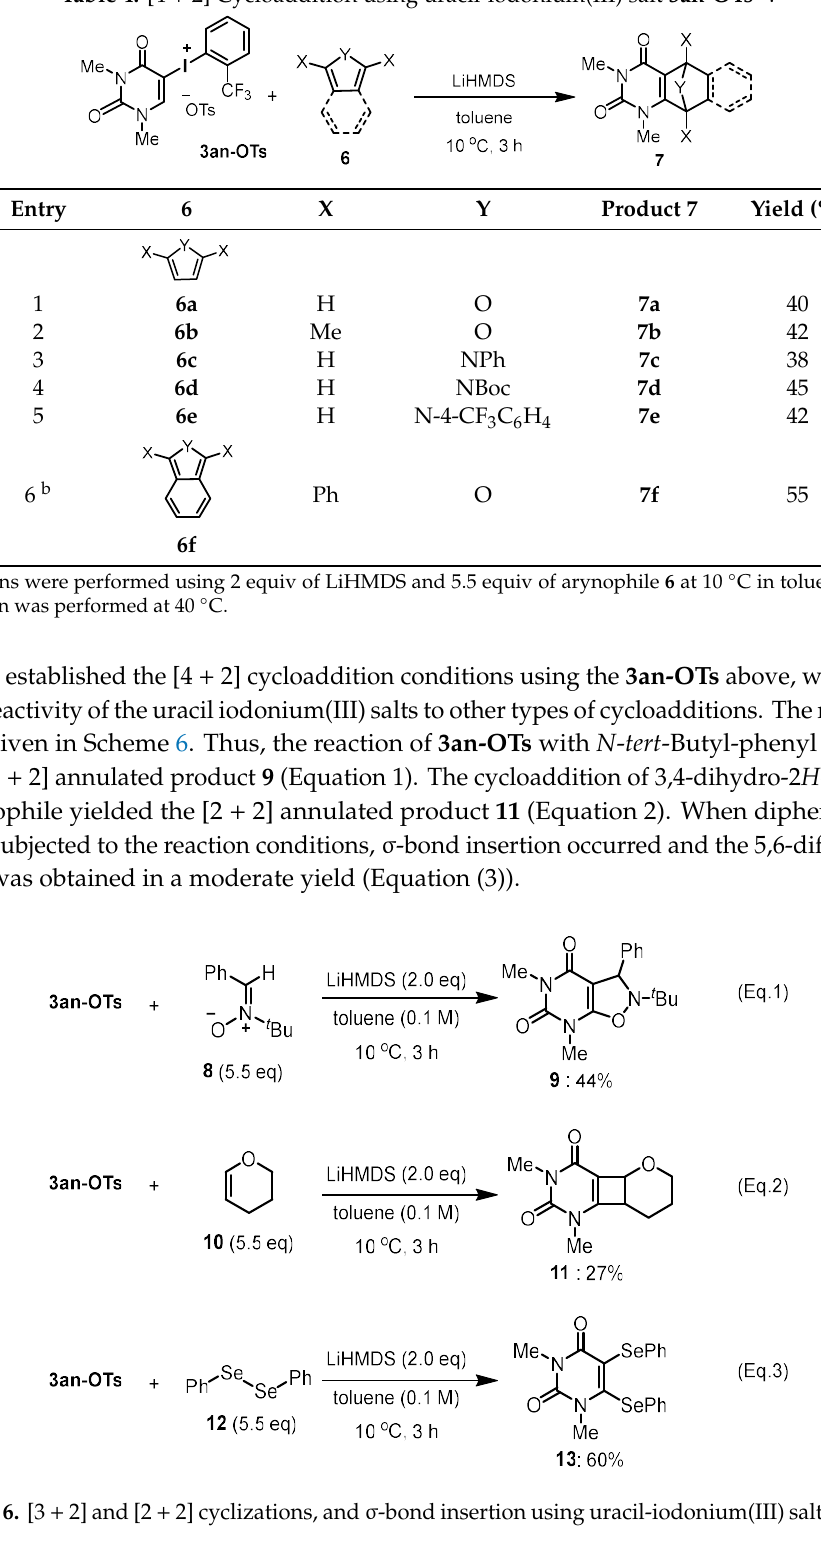
Figure 2. Reported heteroarynes and uracil-heteroaryne analog 14